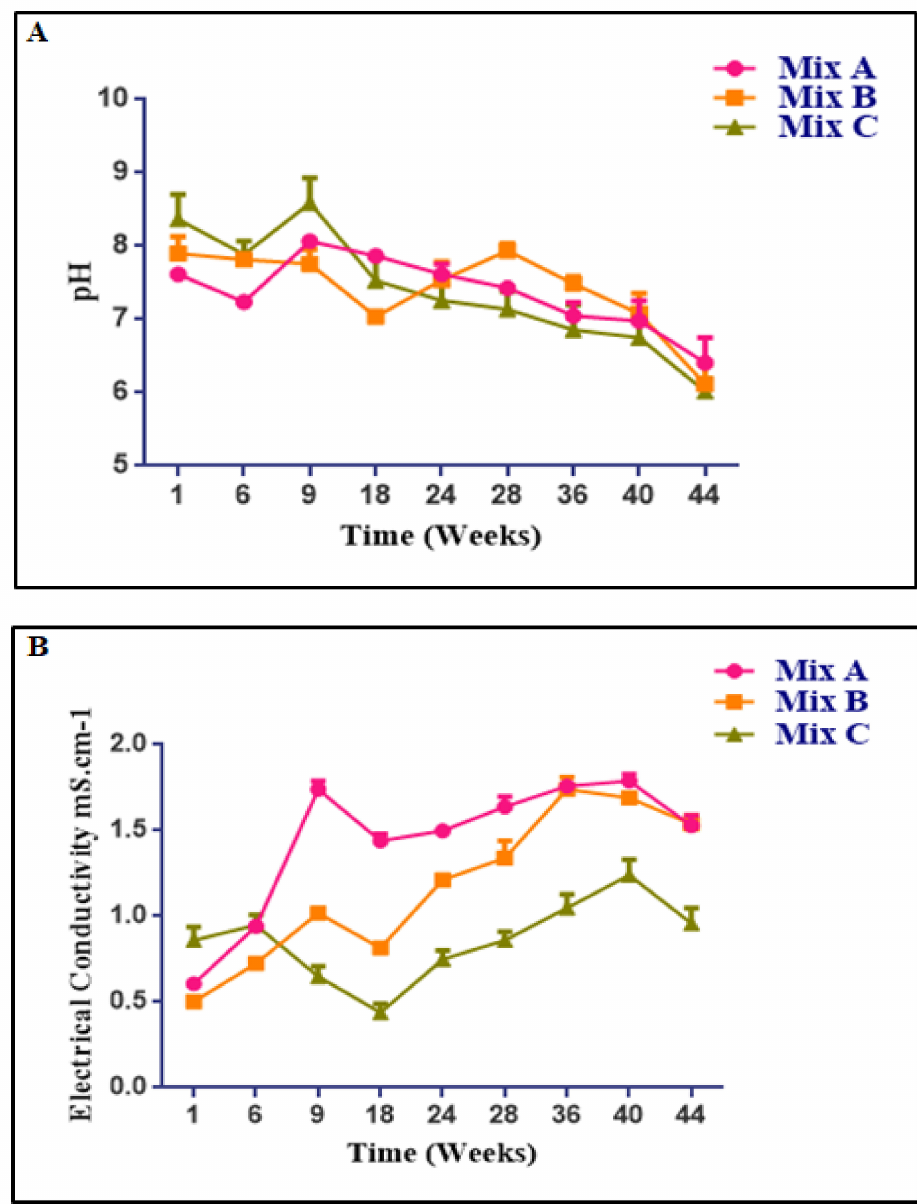
Figure 3. Changes in pH ( A ) and electrical conductivity ( B ) during the composting of di ff erent